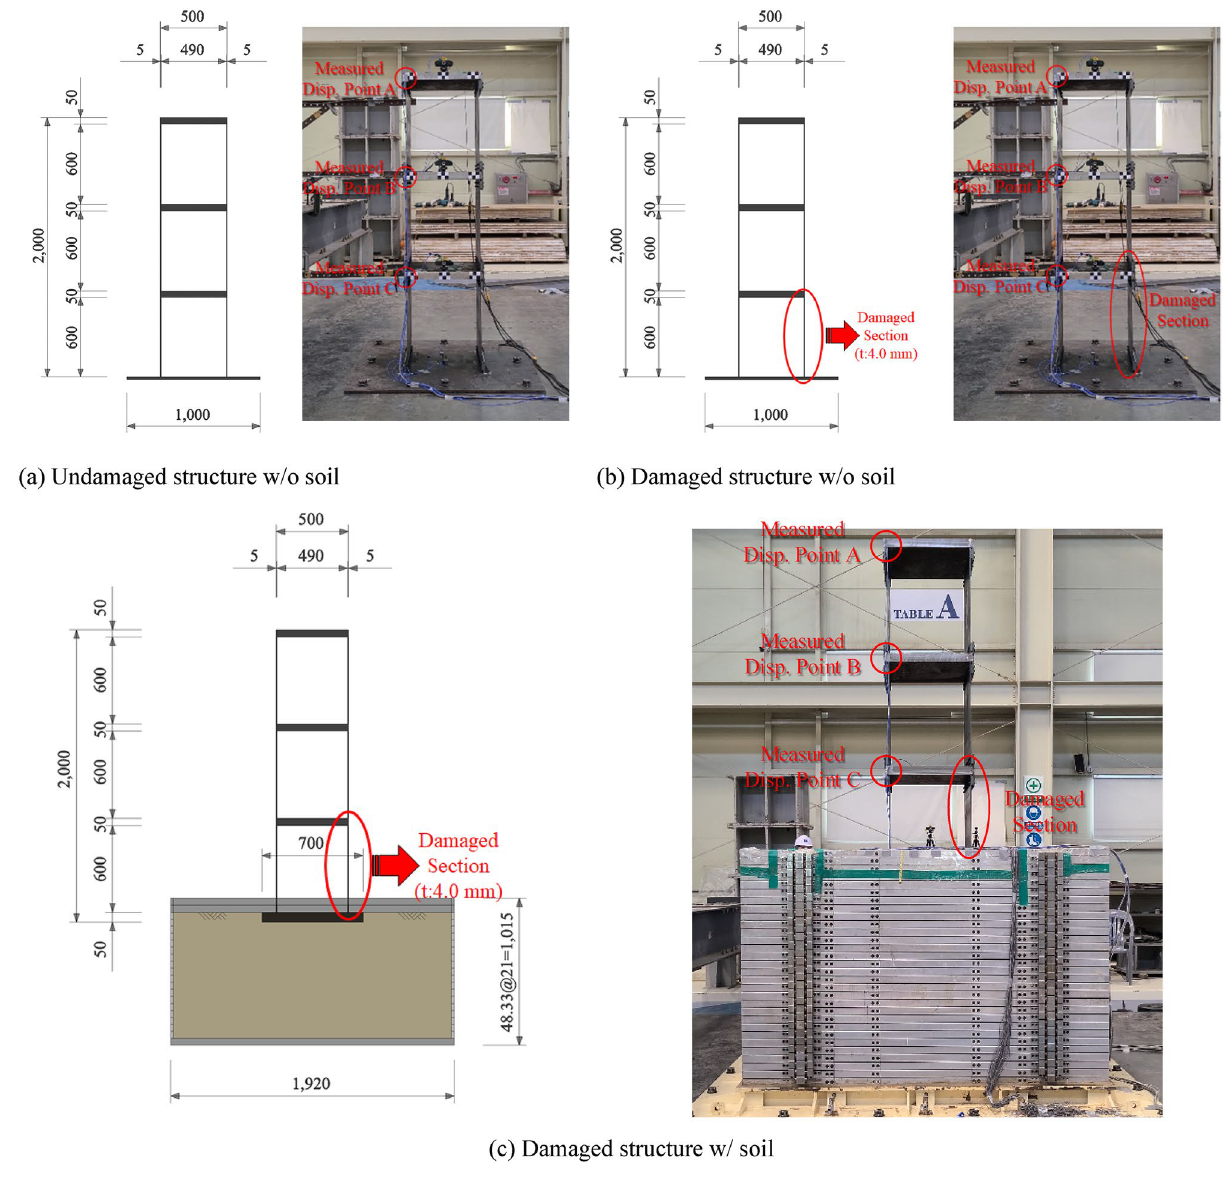
Figure 4. Validation test setup.